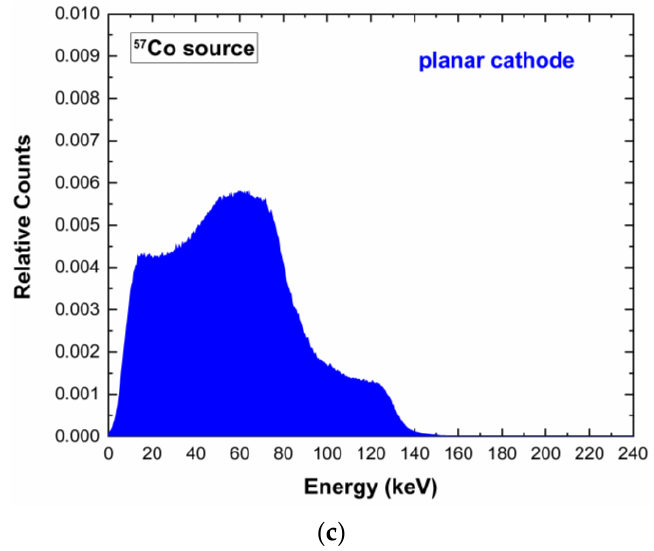
Figure 7. ( a ) 109 Cd, ( b ) 241 Am, ( c ) 57 Co energy spectra of the planar cathode electrode.